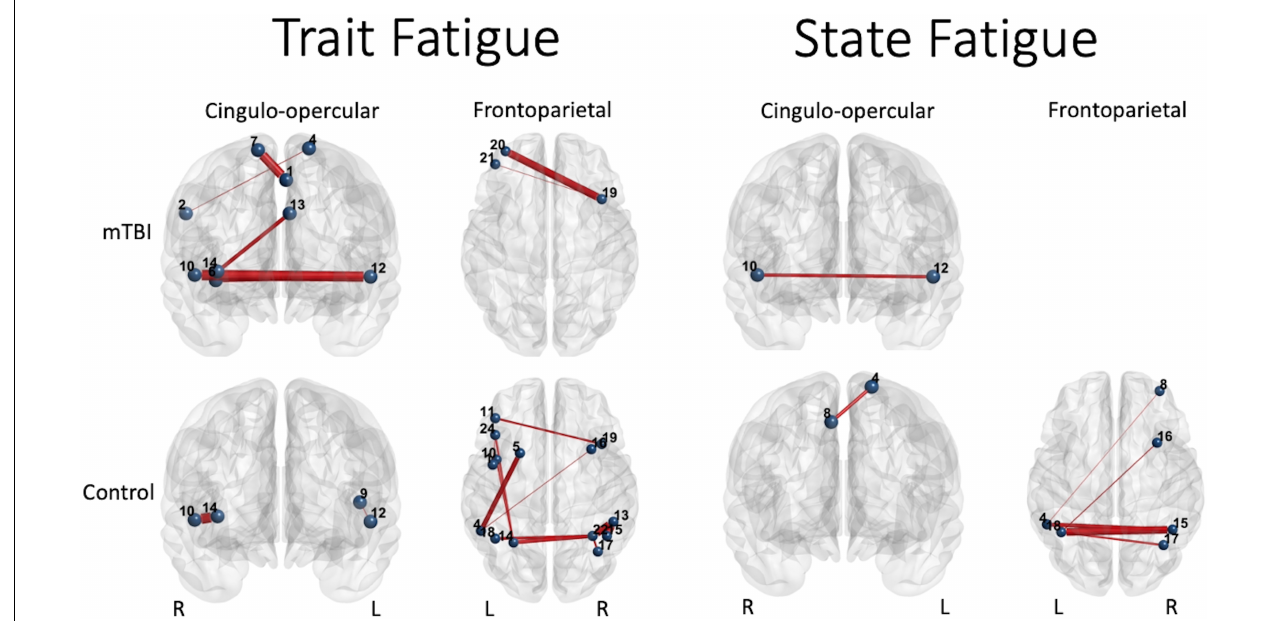
FIGURE 6 | Significant predictors (edge thickness = b coefficient size) of trait (FSS) or state (TC) fatigue tended to involve edges of the CO network in the mTBI group (top row), but not the FP network in the control group (bottom row). The connectivity of several CO edges was predictive of trait fatigue (FSS score) in the mTBI group, specifically weaker connectivity of two edges in the latter part of the 50% effort level second half or 75% effort level first half, and stronger the connectivity of three edges during the most effortful (50 and 75% effort levels) in the second half of the trials (longer TOT). In addition, two FP edges in the highest effort level (75%) at longer TOT (second half) were predictive of trait fatigue in the mTBI group. In contrast, it was largely FP edge connectivity, and specifically the parietal edges, along with only two edges of the CO, that were predictive of trait fatigue in the OC group. Similar group differences were seen for prediction of state fatigue (time constant during the constant effort task), with several FP edges predicting fatigue in the OC group. Interestingly, the weaker connectivity between the right superior temporal gyrus (Mortera et al., 2018) and the left claustrum (Bigler, 2017) in the mTBI group predicted more trait and state fatigue. Note: Edge thickness indicates predictive strength (absolute beta value) from the generalized linear model predicting FSS score (reported in Table 4 ) or the generalized mixed model predicting TC (reported in Table 5 ). Cingulo-opercular network: 1, left medial frontal gyrus; 2, right inferior parietal lobule; 3, right middle frontal gyrus; 4, left superior frontal gyrus; 5, left mid cingulate cortex; 6, right insula 1; 7, right superior frontal gyrus; 8, right medial frontal gyrus; 9, left precentral gyrus; 10, right superior temporal gyrus; 11, left claustrum; 12, left superior temporal gyrus; 13, left anterior cingulate cortex; and 14, right anterior insula. Frontoparietal network: 1, left precentral gyrus; 2, right inferior frontal gyrus triangularis 1; 3, left inferior frontal gyrus triangularis 1; 4, left inferior parietal lobule 1; 5, left middle frontal gyrus 1; 6, right inferior temporal gyrus 1; 7, right superior frontal gyrus orbitalis 1; 8, right middle frontal gyrus orbitalis 1; 9, right precentral gyrus 1; 10, left precentral gyrus 2; 11, left middle frontal gyrus 2; 12, right middle frontal gyrus 1; 13, right inferior parietal lobule 1; 14, left inferior parietal lobule 2; 15, right inferior parietal lobule 2; 16, right middle frontal gyrus 2; 17, right angular gyrus 1; 18, left inferior parietal lobule 3; 19, right middle frontal gyrus 3; 20, left middle frontal gyrus 3; 21, left middle frontal gyrus orbitalis 1; 22, right angular gyrus 2; 23, right middle frontal gyrus orbitalis 2; 24, left inferior frontal gyrus triangularis 2; and 25, left superior medial frontal